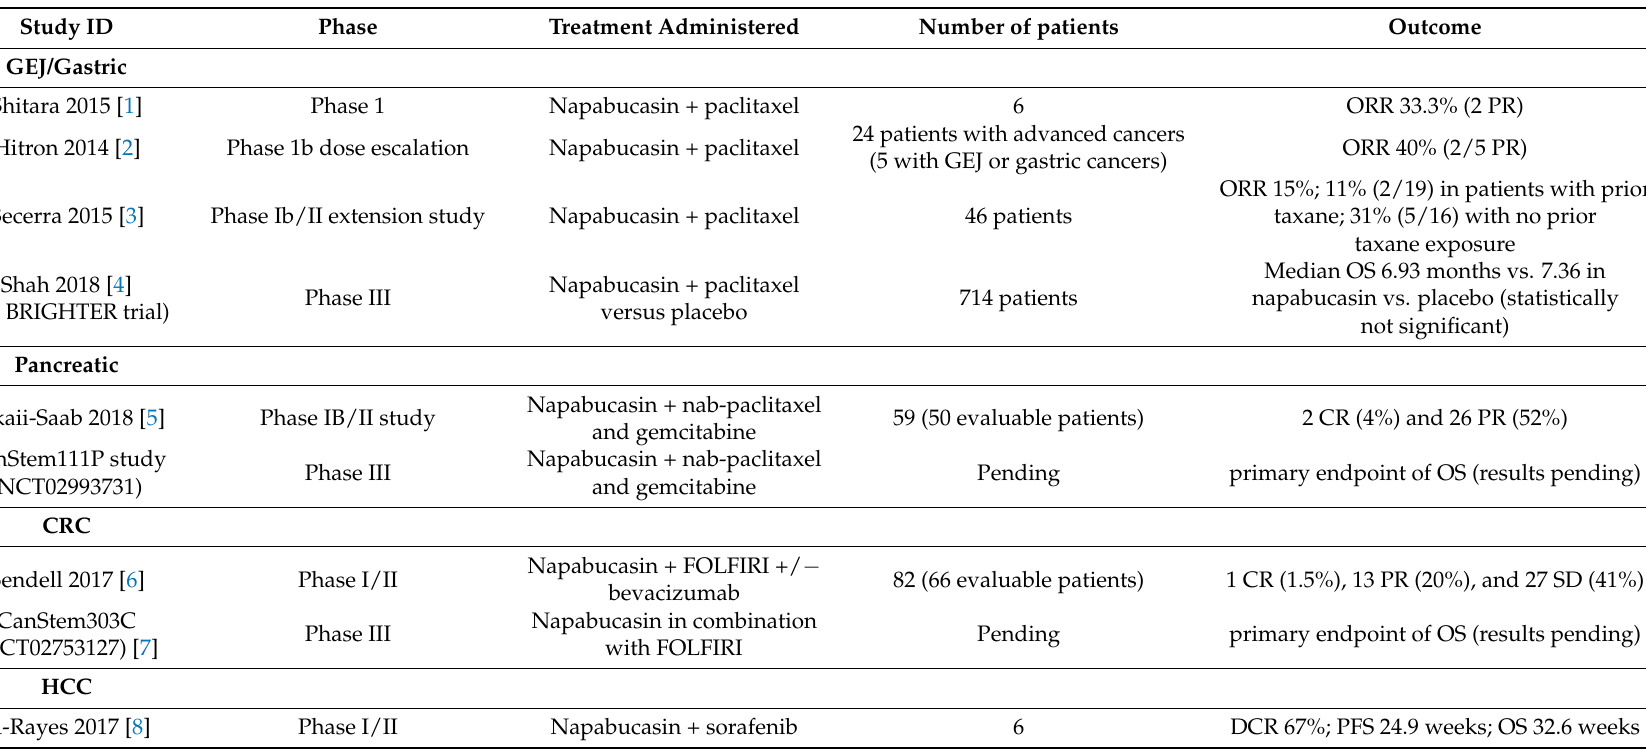
Table 1. Selected trials evaluating napabucasin in gastrointestinal malignancies ORR: Objective response rate; PR: Partial response; PD: Progressive disease; CR: Complete response; OS: overall survival; PFS: Progression-free